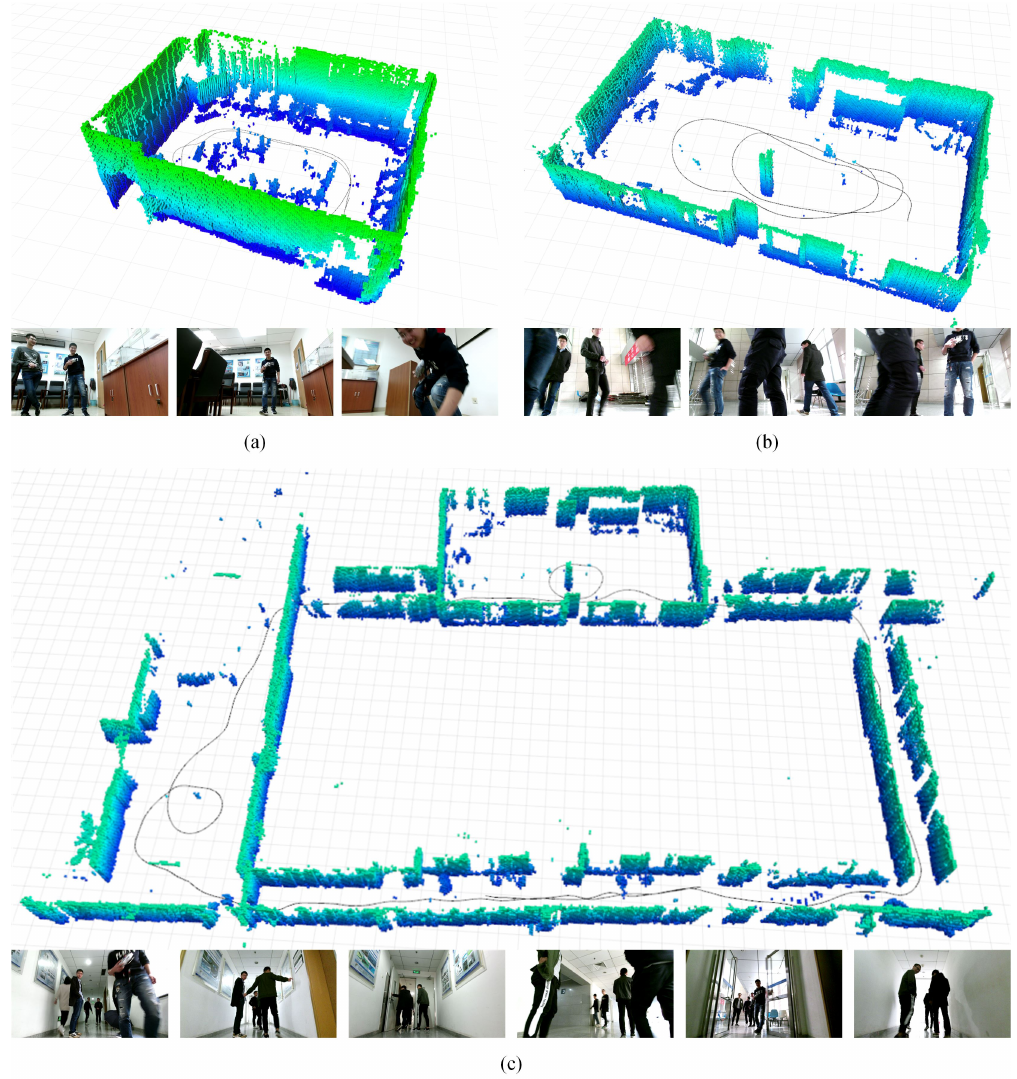
Figure 13. Results of the extension tests. ( a ) 8 m × 6 m office (Voxel size: 0.05 m), ( b ) 15 m × 9 m hall (Voxel size: 0.05 m), and ( c ) 37 m × 27 corridor (Voxel size: 0.1 m). The black lines are the robot trajectories of